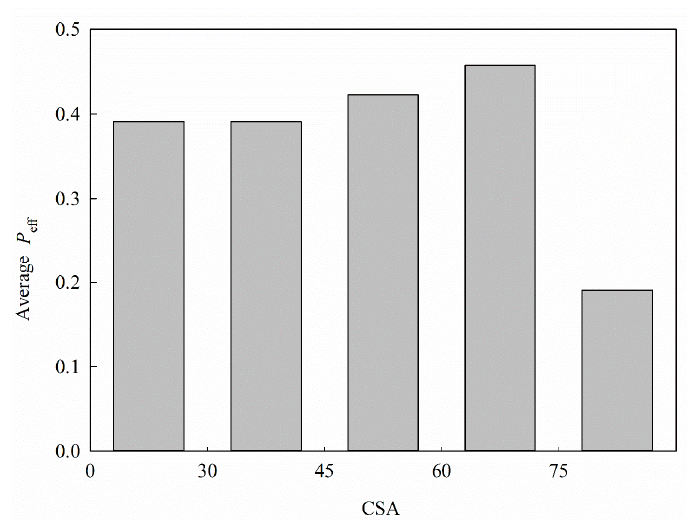
Figure 11. Average P eff vs. the distribution of CSA.